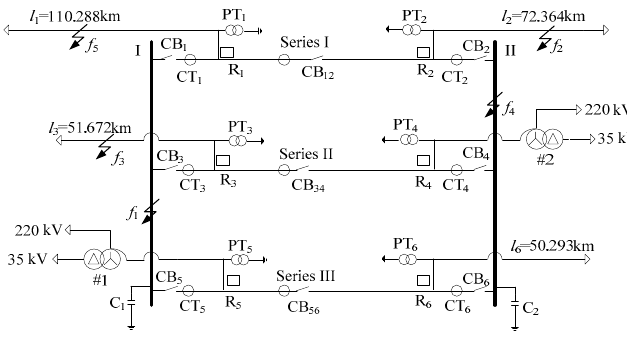
Figure 6. Simulation model.